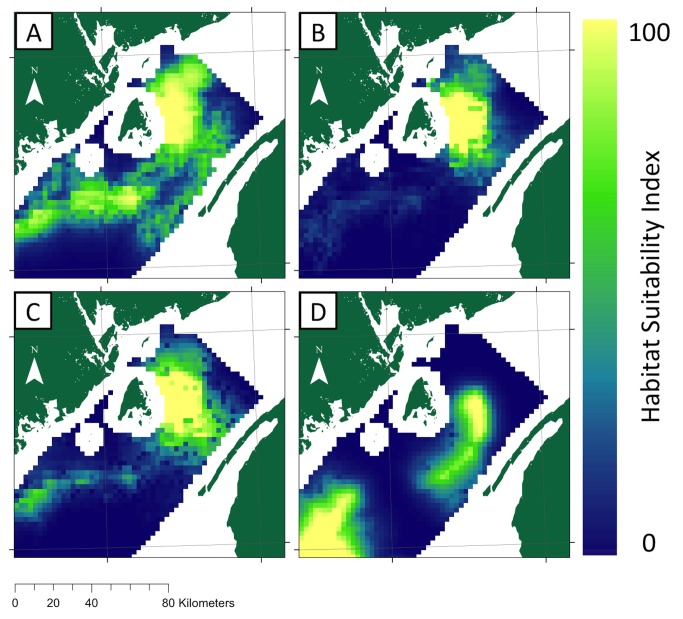
Maps of relative habitat suitability of basking sharks in the lower Bay of Fundy.Maxent distribution models used environmental predictors were chlorophyll-a, sea surface temperature, depth, aspect, slope, and distance to the 0, 50, 100, 150, 200 m contours for (A) July, (B) August, (C) September, and (D) October. Warmer colors indicate higher suitability.